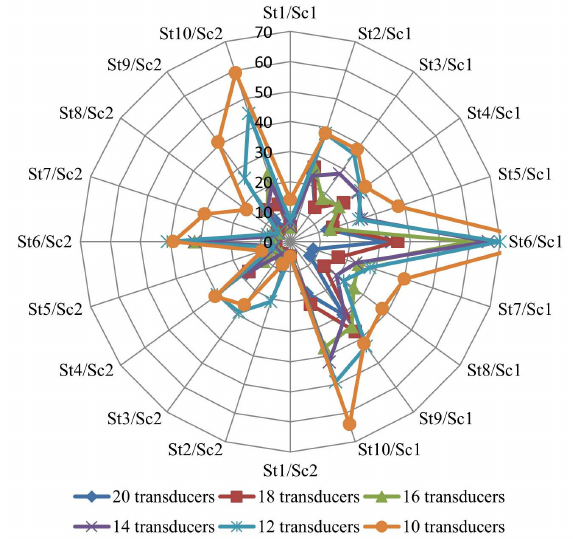
Figure 8. Number of total leaky pipes in the second